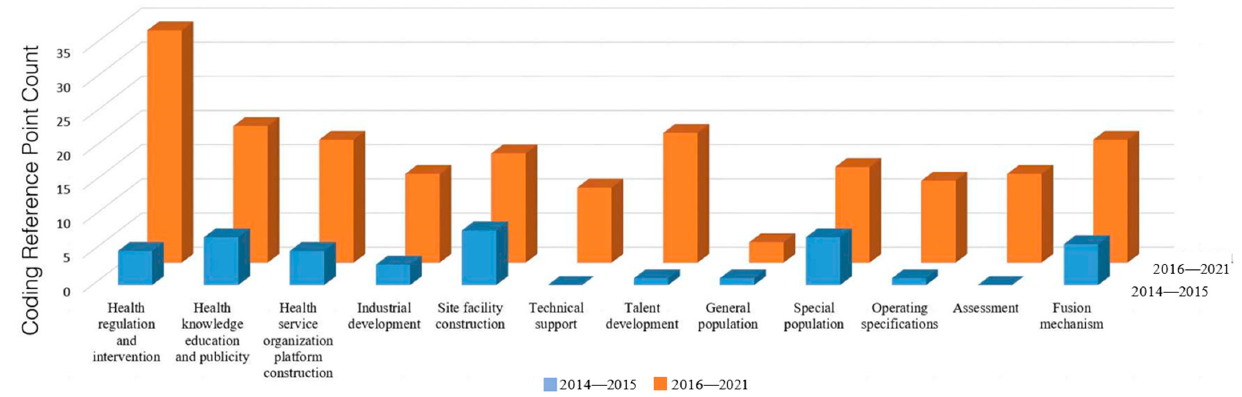
Figure 7. The distribution of the number of stages of the integration of sports and medicine policy.